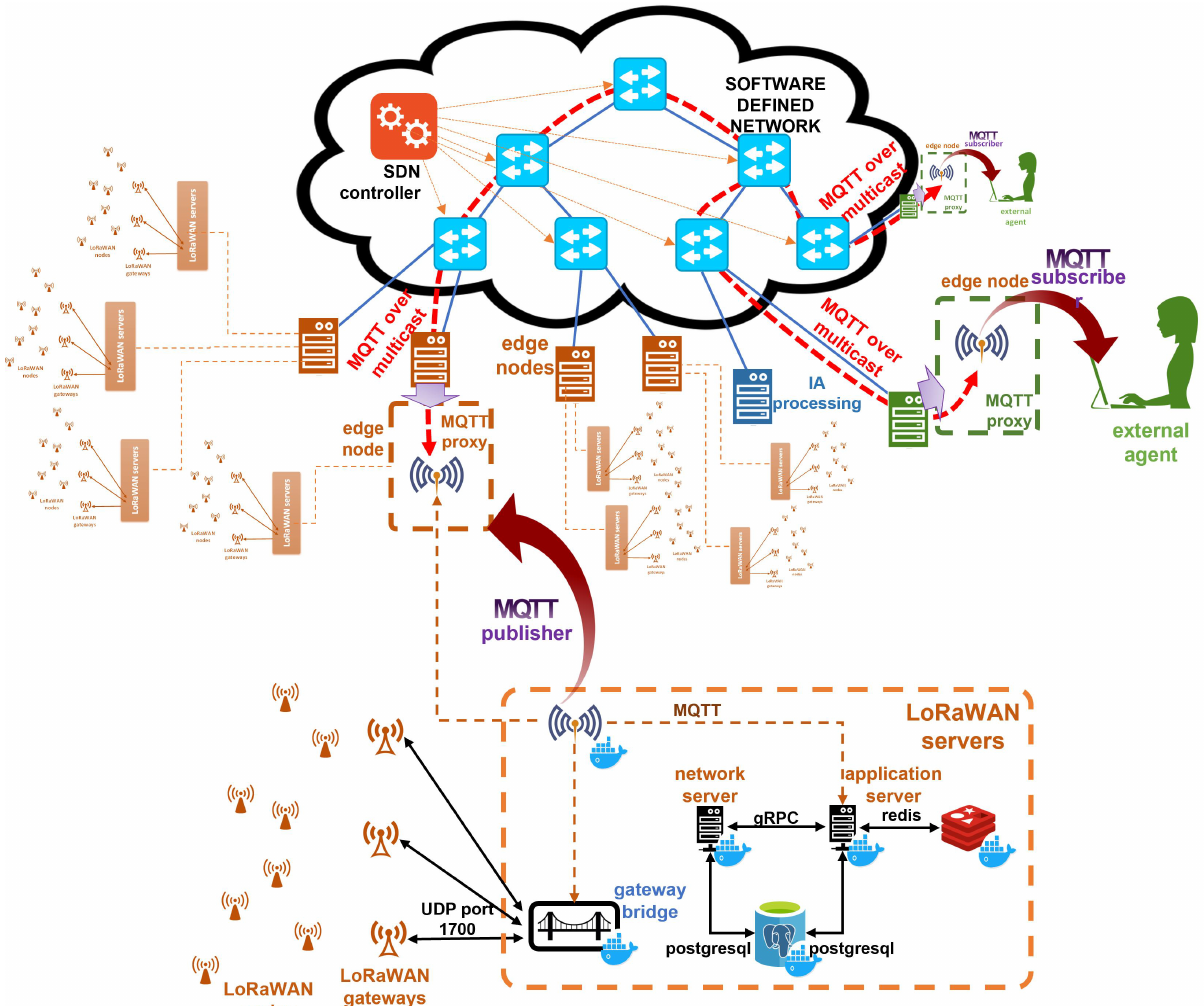
Figure 3. Proposal for an IoT network architecture for the collection, processing and use of environ- mental